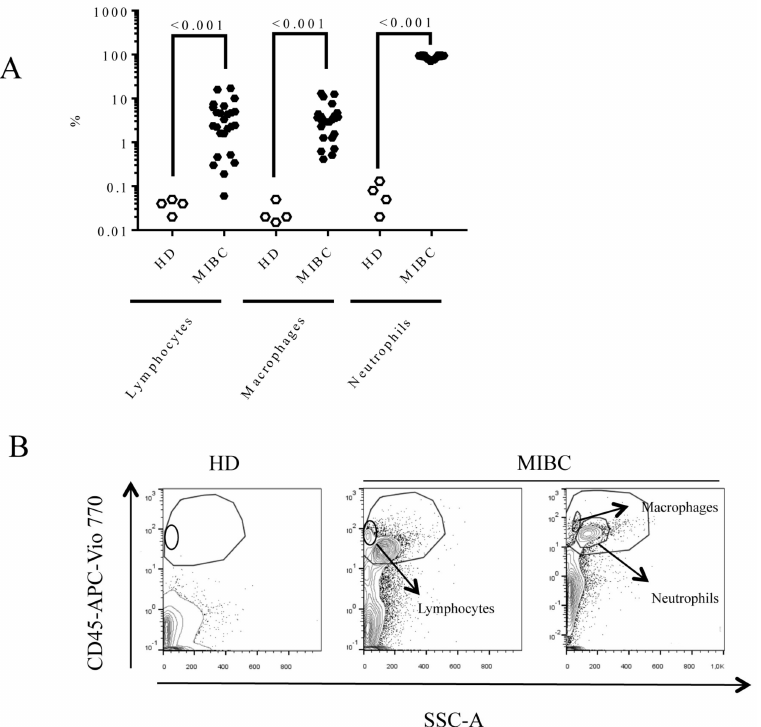
Figure 1. Urine cell composition from MIBC patients and HD. Urine was processed and CD45+ population was determined by flow cytometry as described in Materials and Methods. The percentage of lymphocytes, macrophages, and neutrophils was determined within the CD45+ population. ( A ) Percentage of lymphocytes, macrophages, and neutrophils present in the urine of HD ( n = 4) and MIBC patients ( n = 24); ( B ) dot plots of a flow cytometry example of urine from HD and urine samples from MIBC patients, showing the position of lymphocyte, macrophage, and neutrophil populations. The Mann–Whitney test was used for the comparison of independent